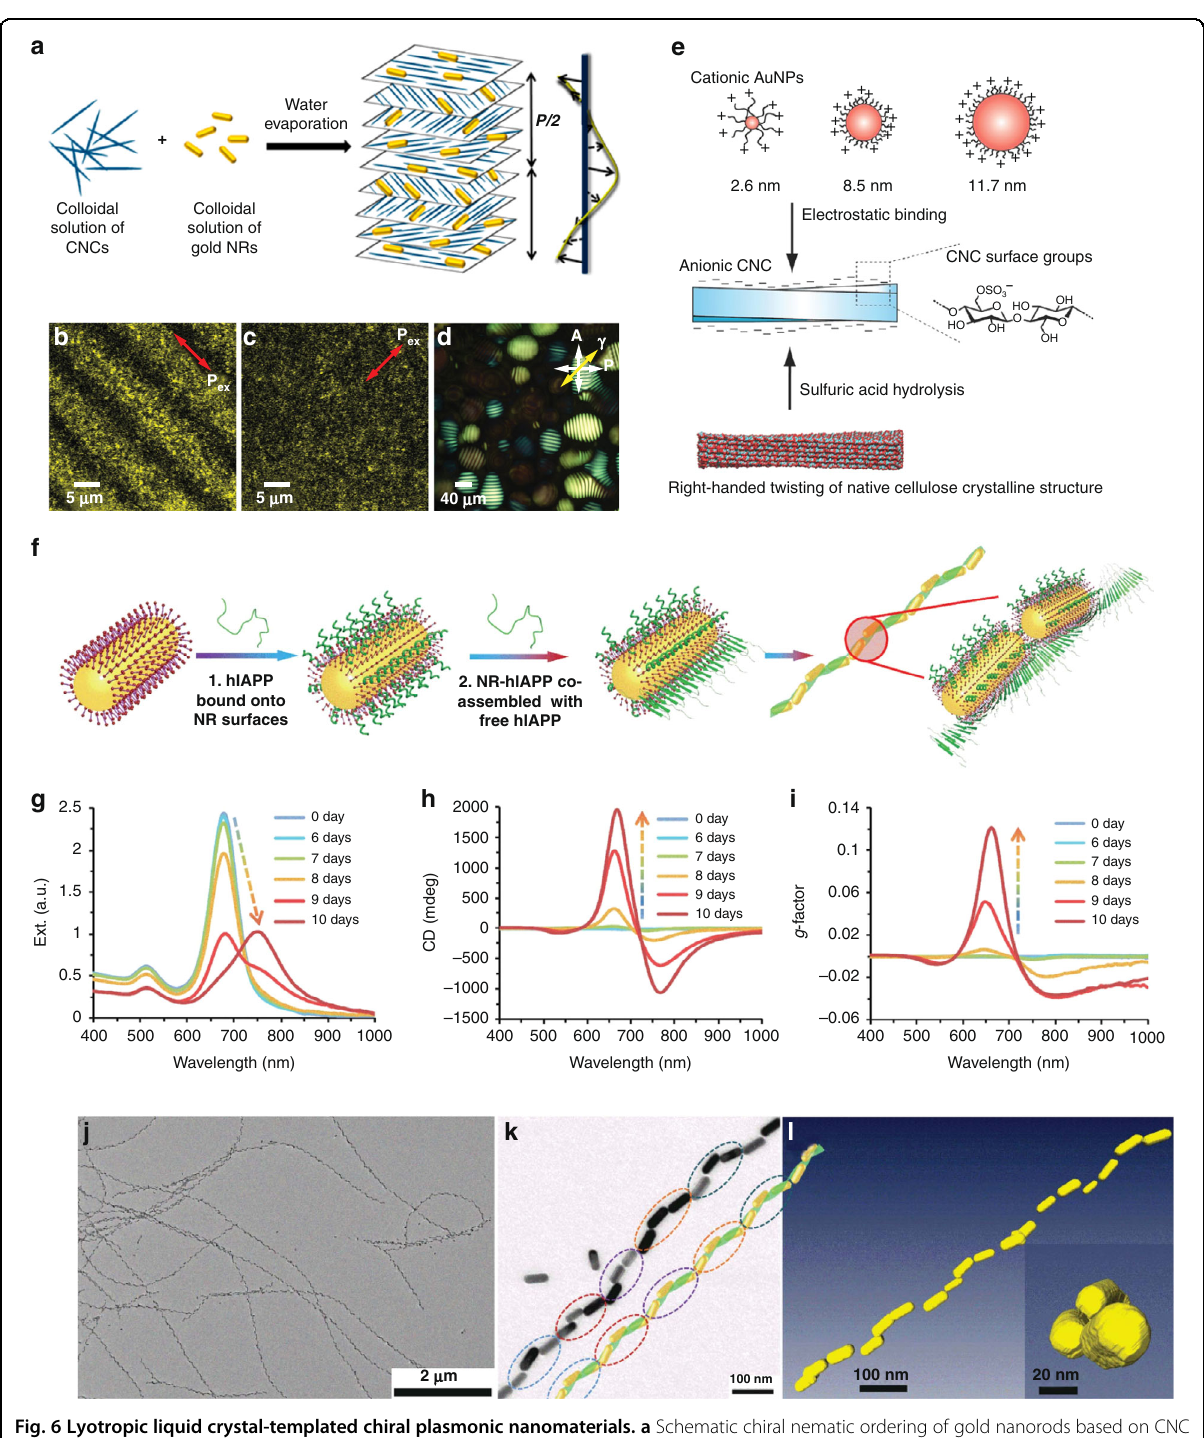
Fig. 6 Lyotropic liquid crystal-templated chiral plasmonic nanomaterials. a Schematic chiral nematic ordering of gold nanorods based on CNC soft template. Reproduced with permission from ref. 206 . Copyright 2014, American Chemical Society. b – d Helicoidal assembly of gold nanorods in colloidal CNC template exhibiting polarization-dependent plasmonic extinction. Reproduced with permission from ref. 210 . Copyright 2014, WILEY- VCH. e Chiral plasmonic nanomaterials based on the electrostatic interactions between CNCs and plasmonic gold nanoparticles. Reproduced with permission from ref. 214 . Copyright 2016, WILEY-VCH. f – l Peptide assembly-enabled liquid crystal-like plasmonic helices with long-range order. Reproduced with permission from ref. 117 . Copyright 2021, AAAS. f Schematics self-assembly process of hIAPP template and gold nanorods. g Extinction, ( h ) CD, and ( i ) g -factor spectra in the co-assembly process. j , k TEM images of nanohelices. l Reconstructed cryo-TEM tomography images of the left-handed